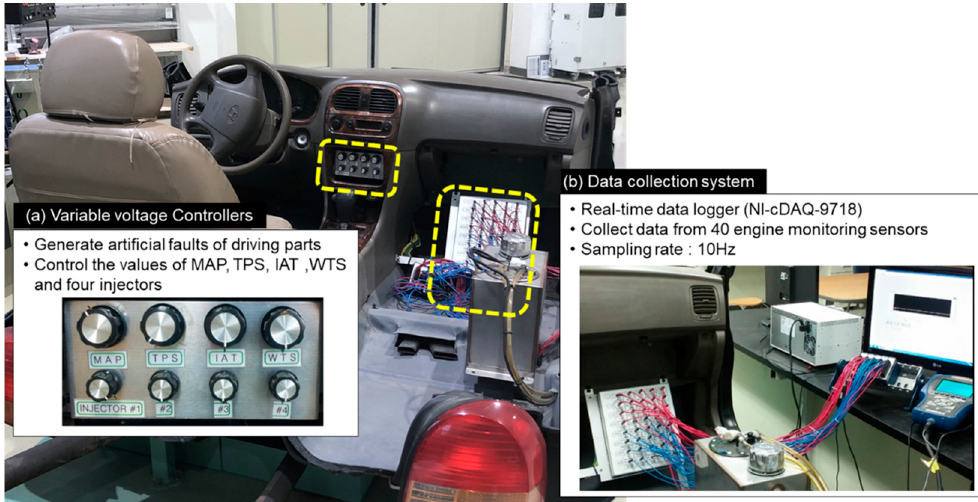
Figure 6. Car engine fault simulator and data collection system: ( a ) variable voltage controllers generate artificial engine faults by changing the gauges of engine components, such as manifold air pressure (MAP), throttle position sensor (TPS), intake air temperature (IAT), water temperature sensor (WTS), and four injectors; ( b ) the data collection system consists of 40 sensors installed at engine components as well as a data acquisition module.